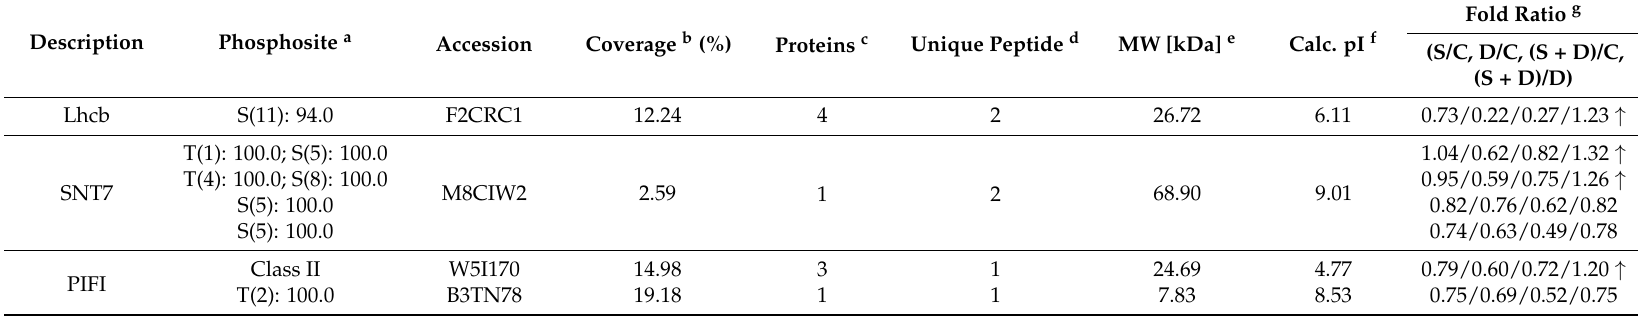
Table 2. Phosphorylated peptides related to the primary photosynthesis metabolism that were differentially and abundantly accumulated in response to nitric oxide (NO) and D